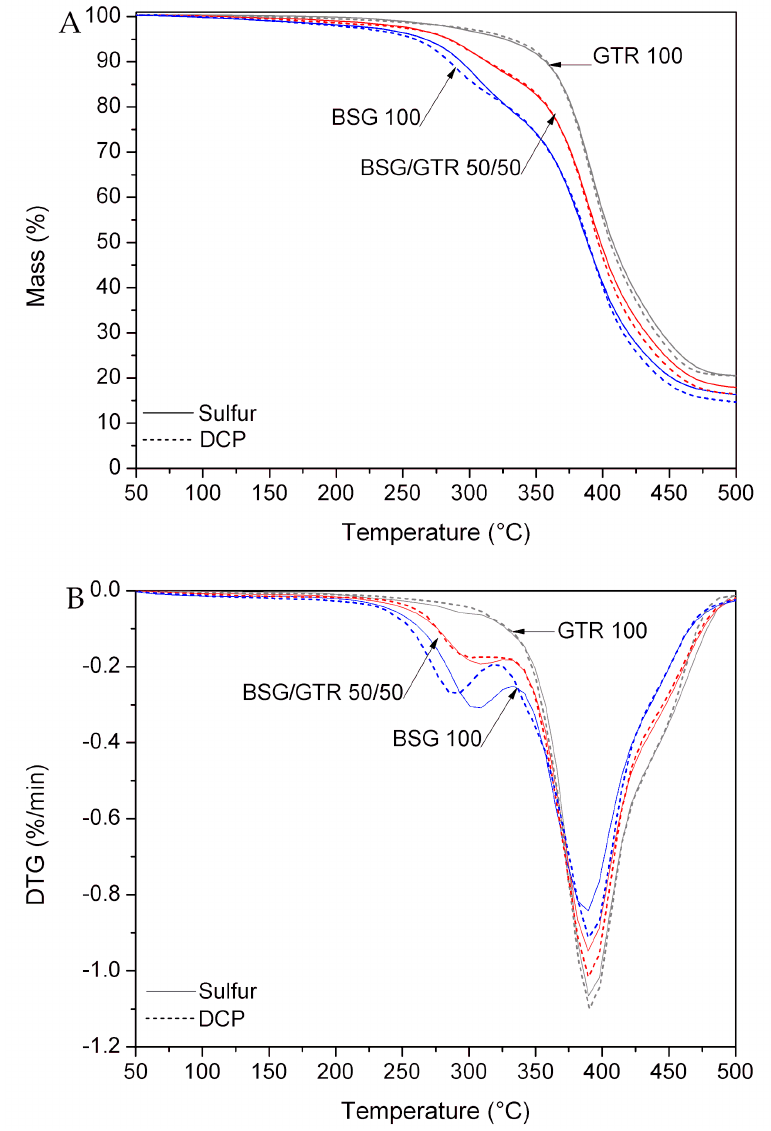
Figure 5. ( A ) TGA and ( B ) DTG curves for NR / BSG / GTR Figure 5. ( A )TGA and ( B )DTG curves for NR/BSG/GTR biocomposites.